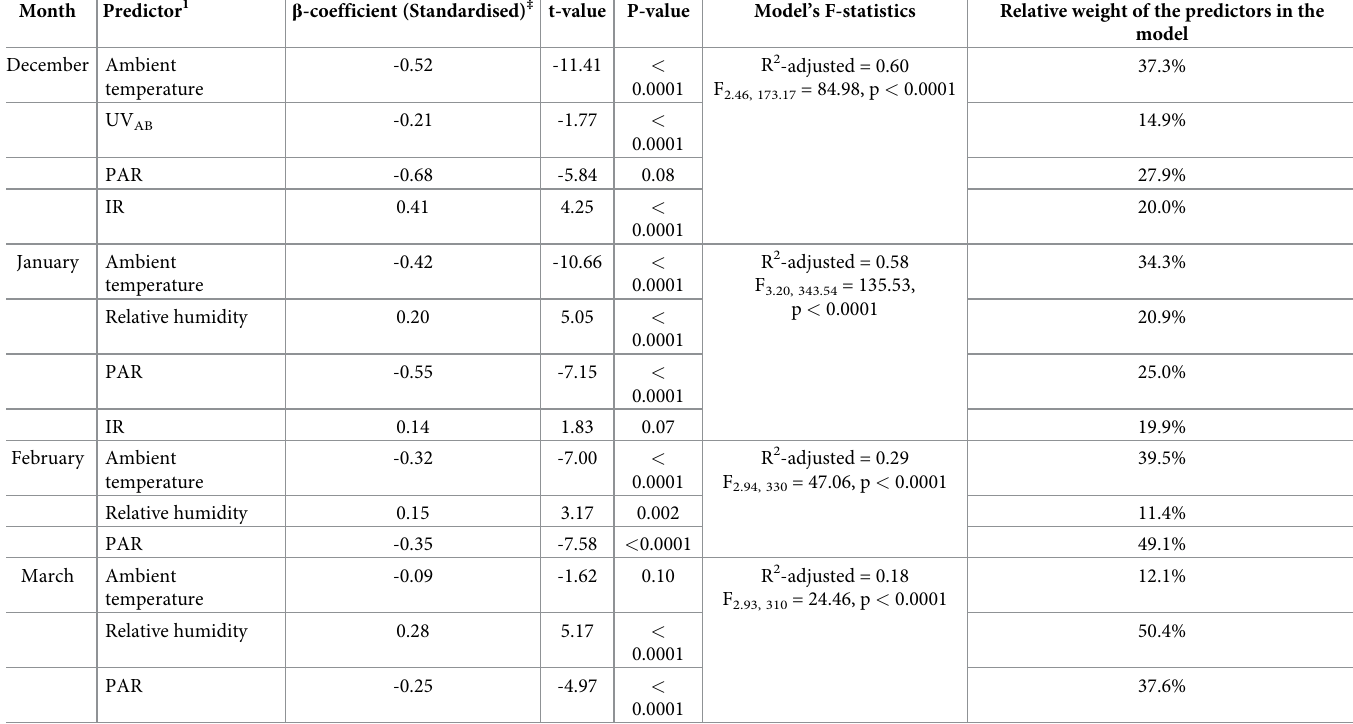
Table 2. Multiple ridge regression analyses (ridge parameter, k = 0.02) on the number of hens in the ‘sun’ across the day in TAS for different observation months. Only variables that significantly contributed to the most parsimonious model are